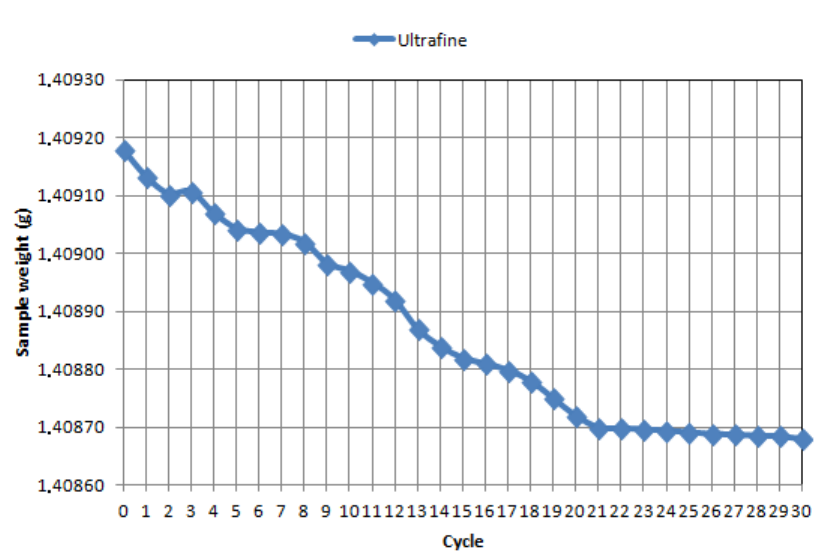
Figure 8. Loss of mass during tribological tests after 30 cycles for sintered WCCo made of ultrafine with 5 N load.